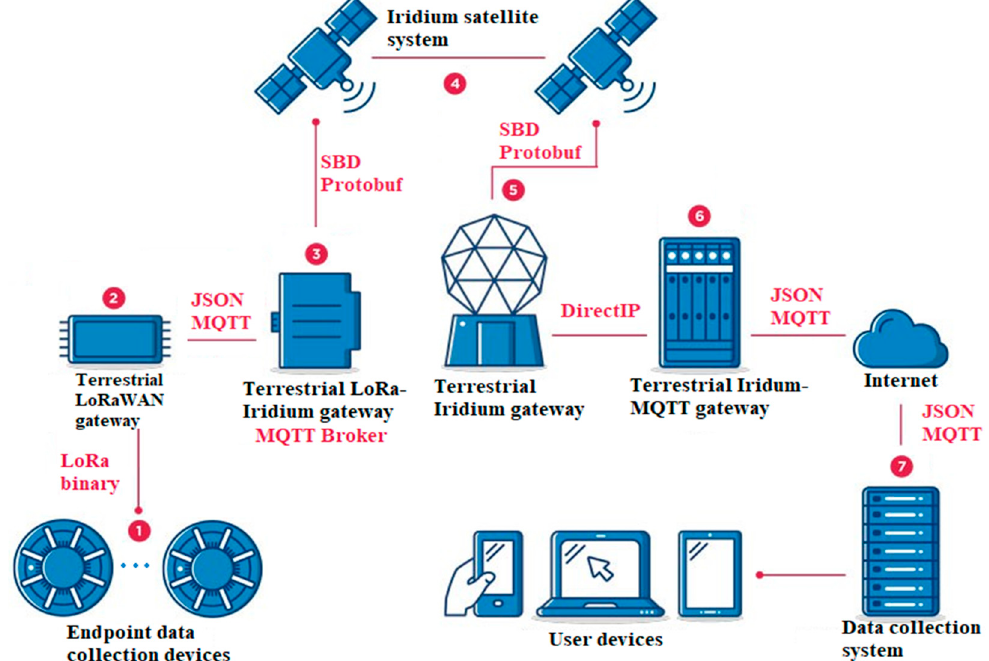
Figure 2. Heterogeneous long range (LoRa)-Iridium network architecture.